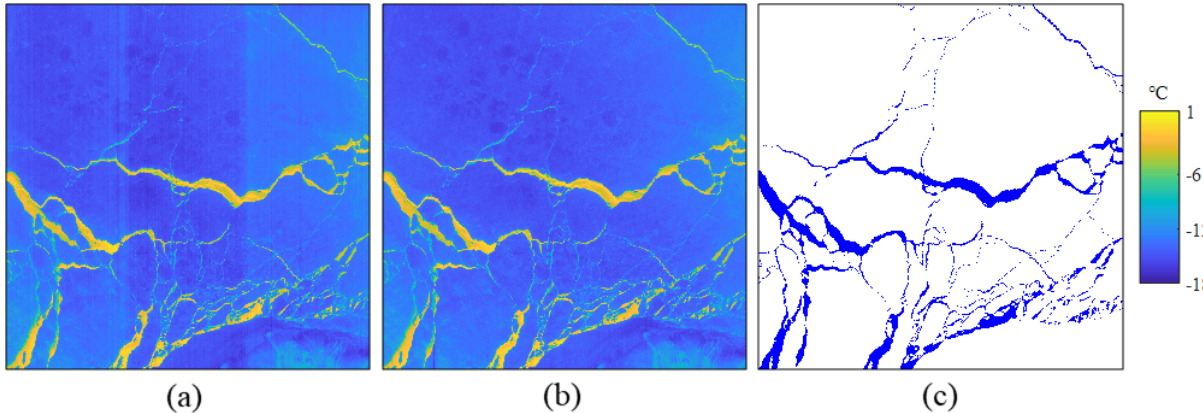
Figure 2. The IST images obtained from the Landsat-8 images on 31 March 2020, and the corresponding corrected IST image: (a) the original IST image, (b) the IST image corrected by the median filtering method, and (c) the manually produced lead map. The lead and ice-covered areas are marked as blue and white, respectively.